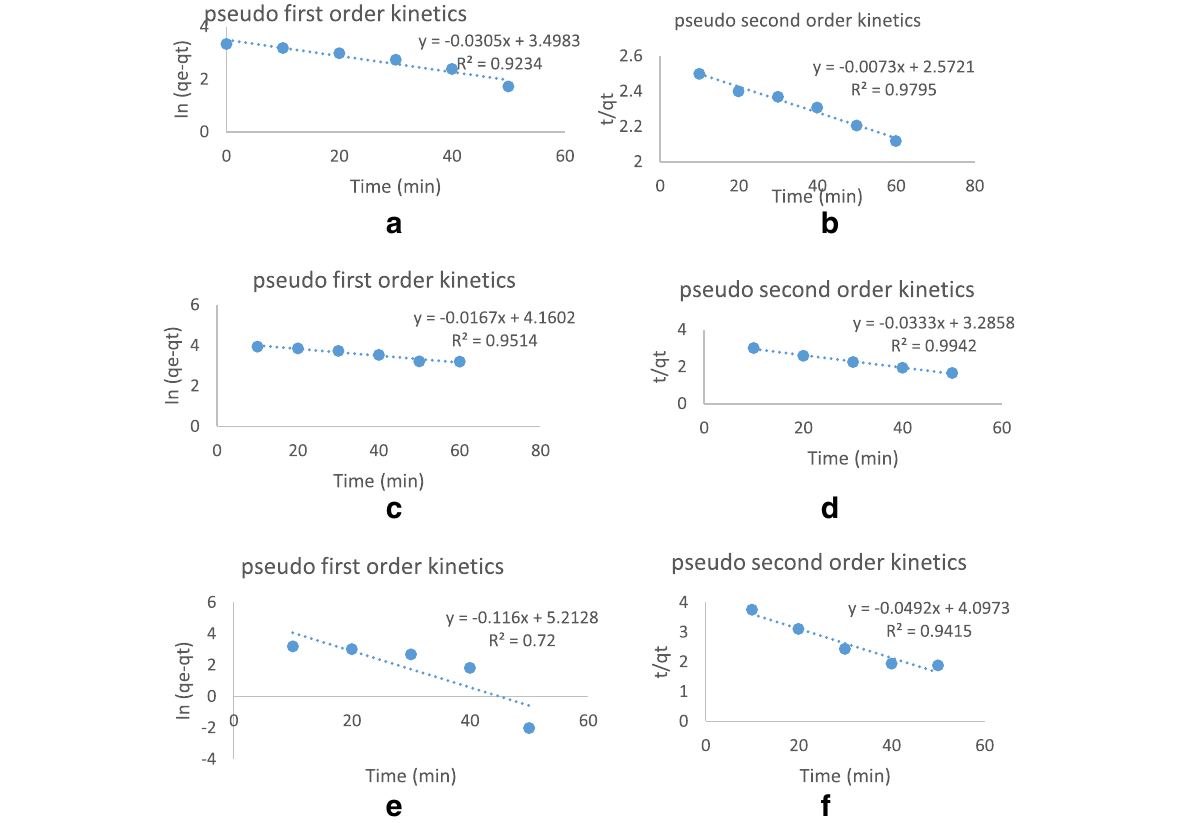
Fig. 6 a Pseudo-first-order adsorption kinetics of cefadroxil, b pseudo-second-order adsorption kinetics of cefadroxil, c pseudo-first-order adsorption kinetics of cefprozil, d pseudo-second-order adsorption kinetics of cefprozil, e pseudo-first-order adsorption kinetics of cefradine, and f pseudo-second-order adsorption kinetics of cefradine on MSN particle at optimum